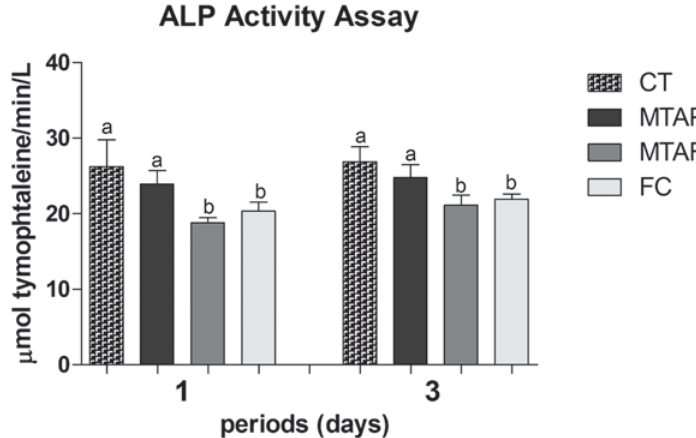
Figure 4- Alkaline phosphatase (ALP) enzyme activity in human dental pulp cells (hDPCs) exposed to MTA Plus (MTAP), MTA Fillapex (MTAF), FillCanal (FC) and culture medium used as control (CT). Bars with different letters represent